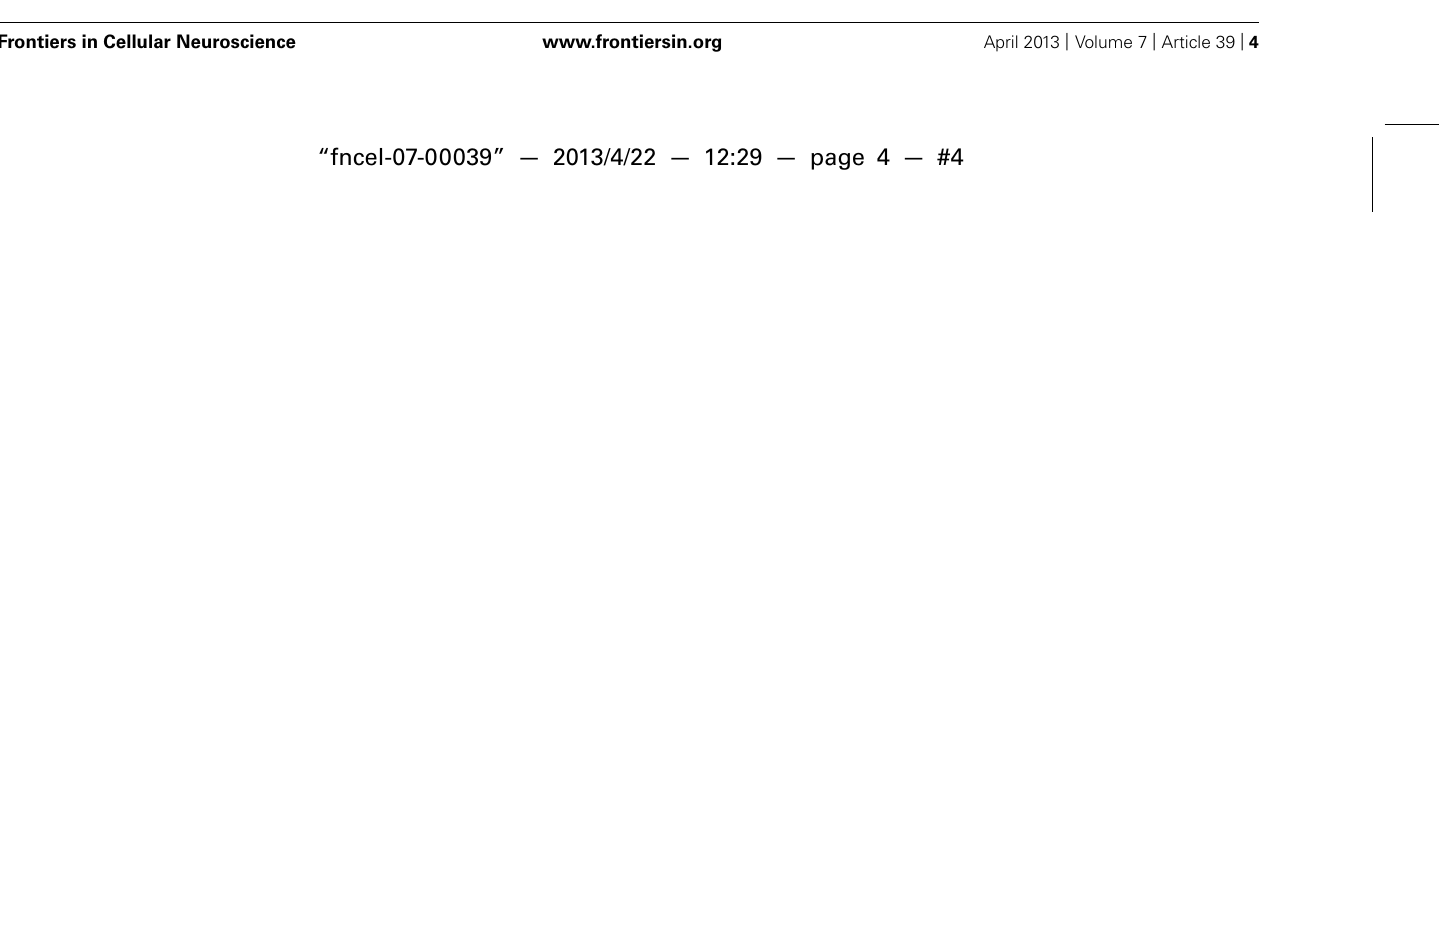
FIGURE 2 | Schematic model of the proposed pathways mediating D -serine synthesis and release. Activation of presynaptic neuron results in release of glutamate that binds to AMPA receptors on neighboring astrocytes and causes release of D -serine. D -serine released from astrocytes binds to synaptic NMDAR-containing GluN2A subunits. Extrasynaptic receptors